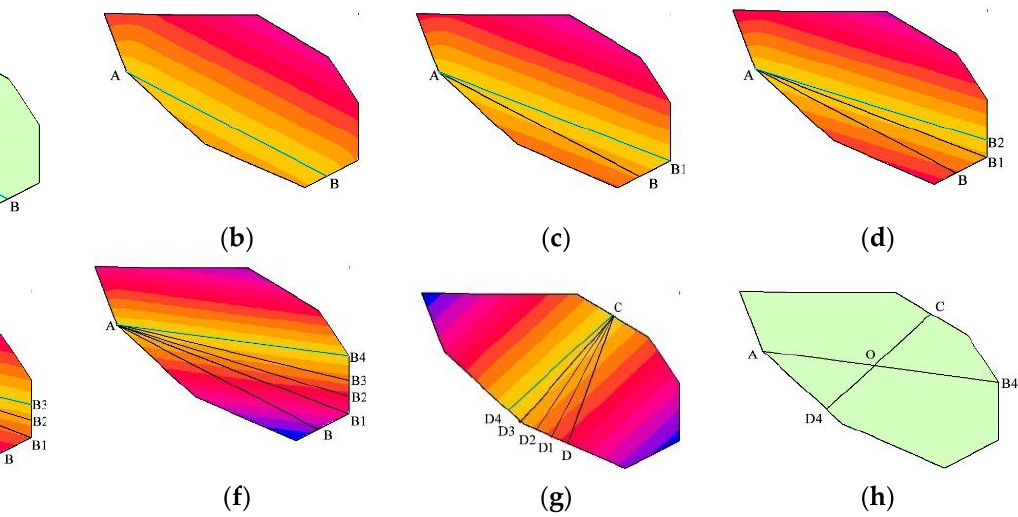
Figure 2. Centroid computing of polygon P : ( a ) original polygon; ( b ) result of the Euclidean distance transformation of Line AB ; ( c ) result of the Euclidean distance transformation of Line AB 1 ; ( d ) result of the Euclidean distance transformation of Line AB 2 ; ( e ) result of the Euclidean distance transformation of Line AB 3 ; ( f ) result of the Euclidean distance transformation of Line AB 4 ; ( g ) computing procedures of the second candidate centroid balance line; ( h ) result of the final centroid of the polygon P . For the concave polygon Q , its computing procedures of the candidate centroid balance line is the same as the above convex polygon P (Figure 3), which is not discussed in detail